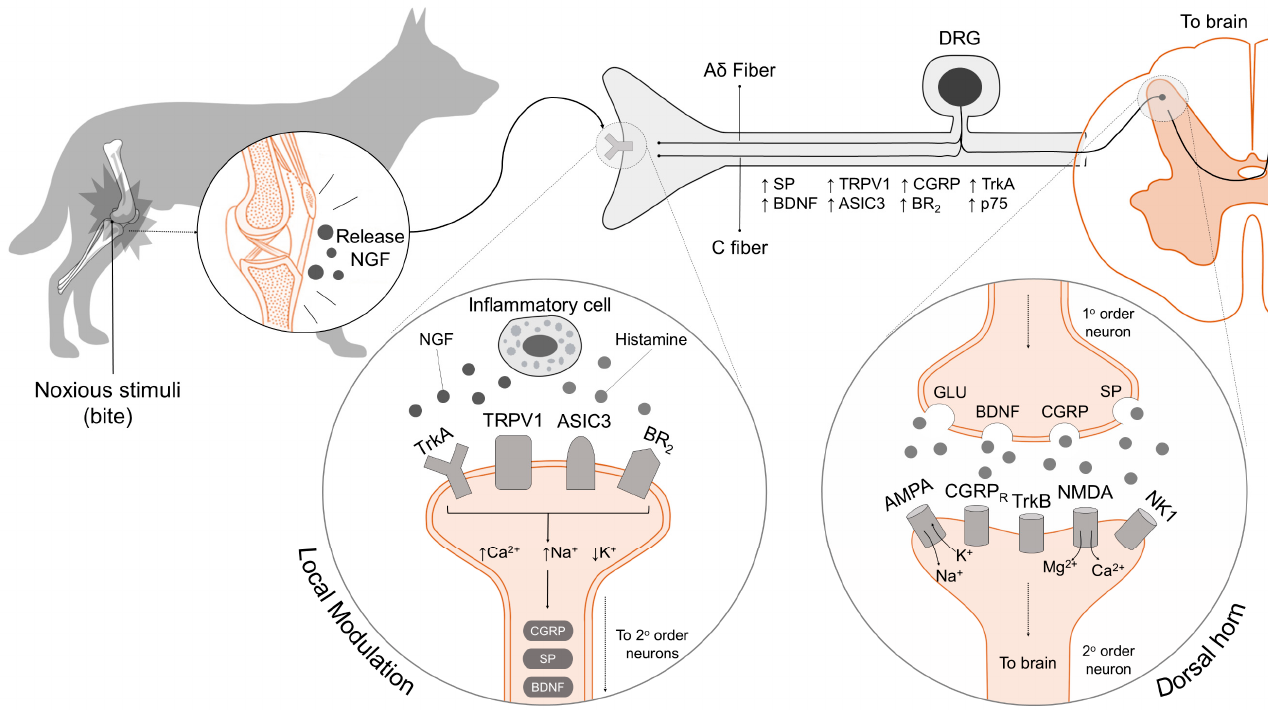
Figure 6. Sensitization of the nervous system. Inflammatory mediators (histamine, NGF) released after tissue injury (bites) bind to peripheral receptors located on first-order neurons. Activation of these receptors (TrkA, TRPV1, ASIC3, BR 2 ) and ionic channels, such as Na + , Ca 2+ and K + , modulates and enhance the excitability of the primary afferent nerve cells. When the nociceptive signal reaches the dorsal horn of the spinal cord, it causes the release of pronociceptive neurochemicals including GLU, SP, CGRP, and BDNF, from the primary neurons to the second-order neuron receptors, mainly AMPA, NMDA, NK1, CGRPR, and TrkB. These receptors promote the transmission of the excitatory signaling to the brain and cortical structures, where the perception of pain is consciously recognized.